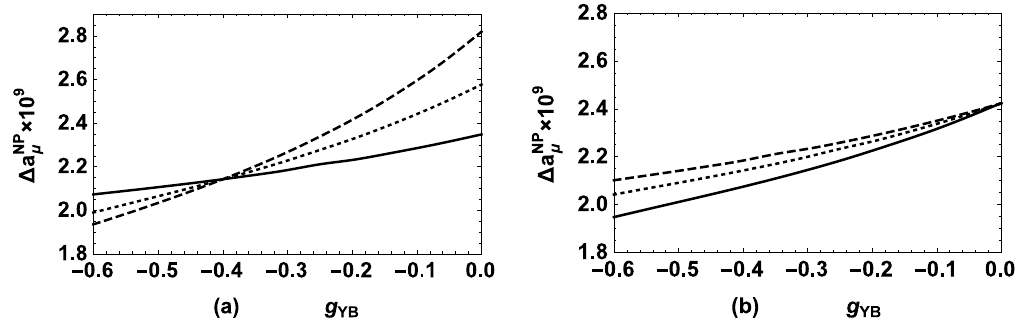
Figure 6 . Taking M BL = 0 . 6 TeV , M BB 0 = 0 . 5 TeV , µ 0 = 0 . 8 TeV , we plot ∆ a NP for g = 0 . 4 (a), where the solid, dotted, dashed lines denote the numerical results for tan β 0 = B 1 . 15 , 1 . 3 , 1 . 45 respectively. Similarly, ∆ a NP solid, dotted, dashed lines denote the numerical results for g